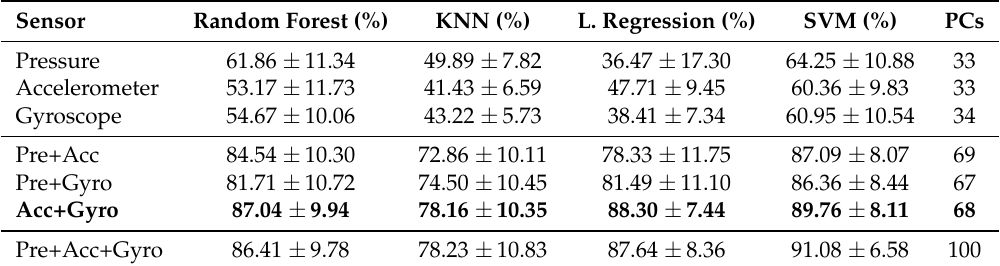
Table 4. Precision of the gait pattern classification using the variance combinations of the smart shoes sensor features based on the optimal number of principal components (PCs). Pre, Acc and Gyro denote pressure sensor, accelerometer and gyroscope, respectively.